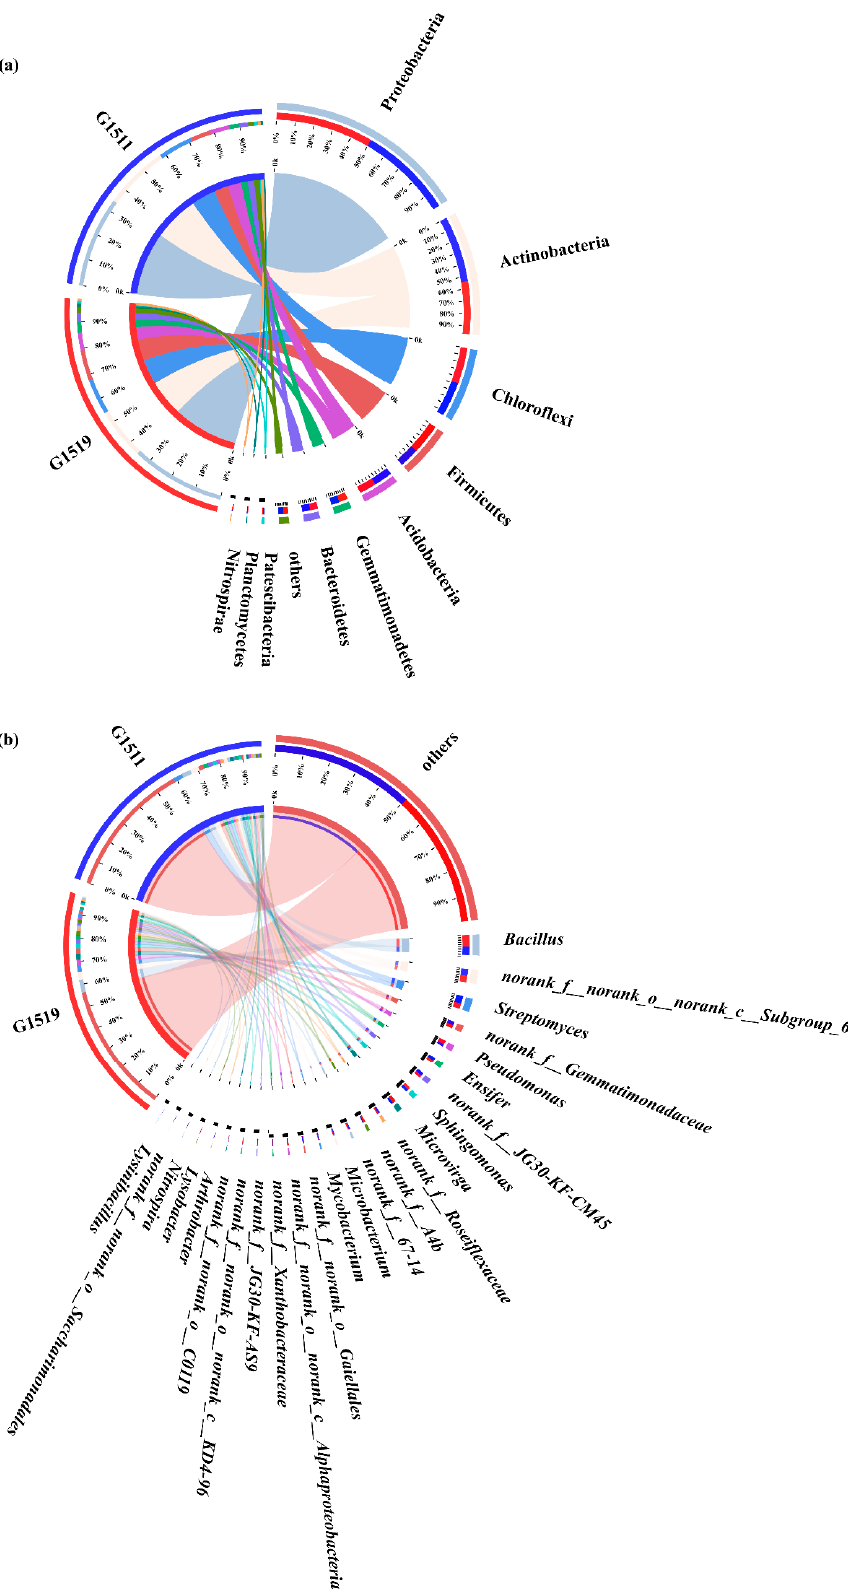
Figure 3. Compositions of soil bacterial communities in the two pumpkin cultivars (G1519 and G1511) at the phylum level ( a ) and genus level ( b ).